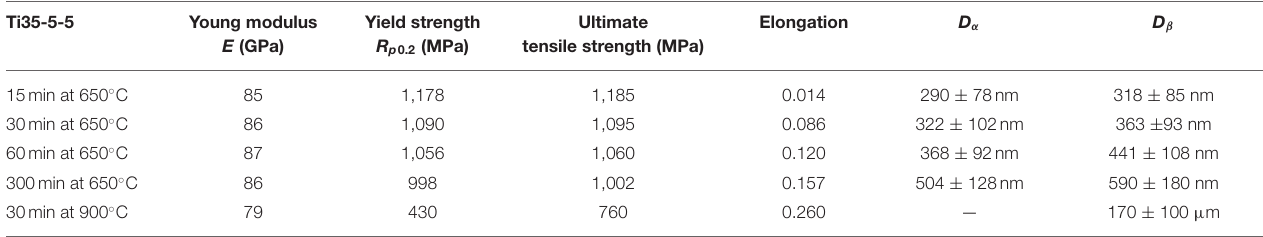
FIGURE 7 | Tensile true stress as a function of the true strain at a strain rate of 10 − 4 s − 1 . For better readability, the curves are plotted from a stress of 300 MPa and up to 0.14 deformation. In black are the two phase α / β samples annealed at 650 ◦ C for different holding times, and in red are the alloys annealed at 900 ◦ C for 30min, which are fully bcc β with the corresponding electron backscatter diffraction (EBSD) maps. (A) Ti35-5-5 and (B) Ti35-6.5-6.5.